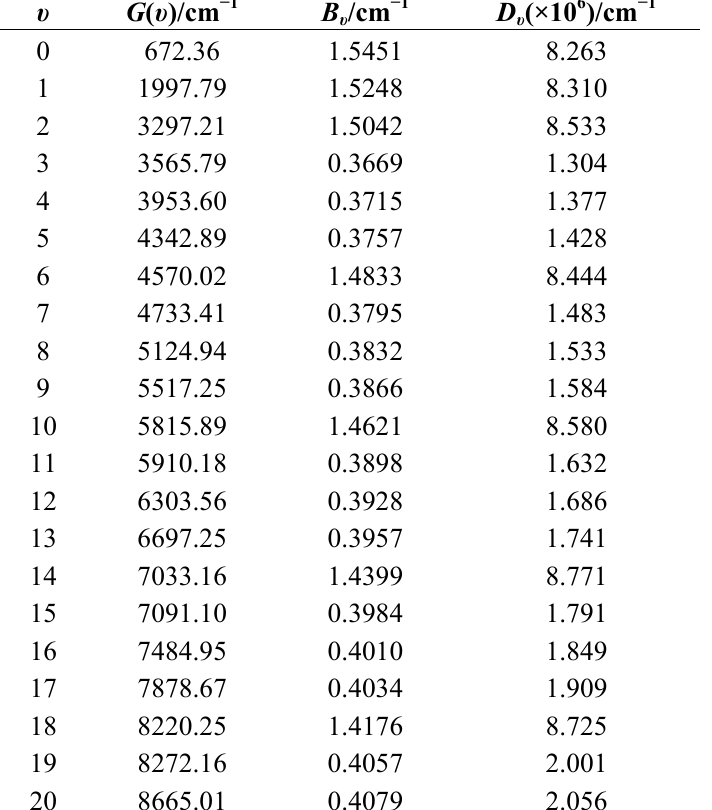
Table 7. Vibrational levels and molecular constants for the B 2 Σ + state of BeF